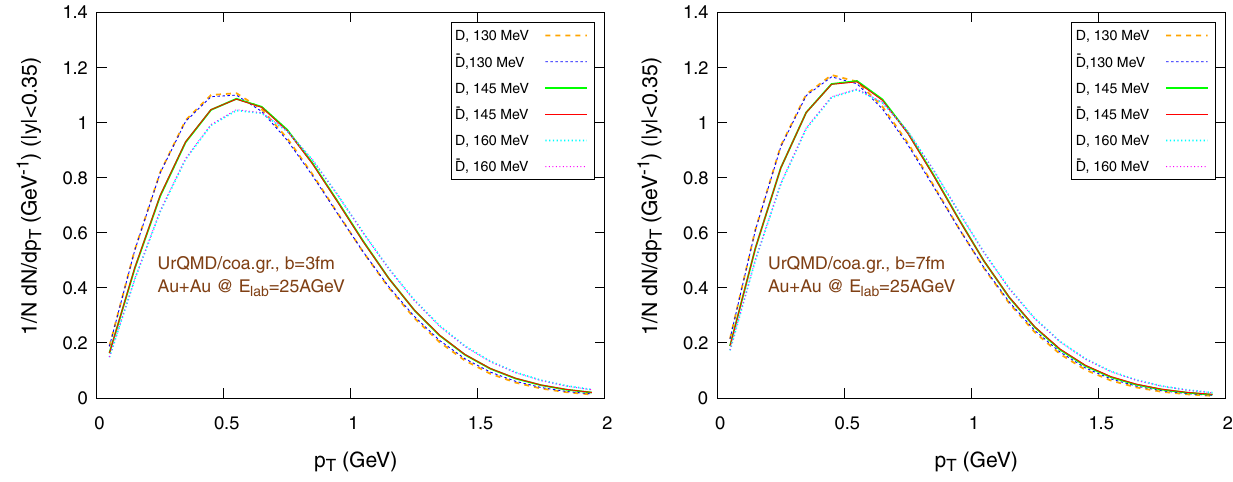
Fig. 11 Normalized 1 / N d N / d p T distribution of the final D / ¯ D mesons, in the rapidity range | y | < 0 . 35, for Au+Au collisions at E lab = 25AGeV, using the UrQMD/coarse-graining approach. The hadronization parameters are (cid:23) p = 0 . 05 and